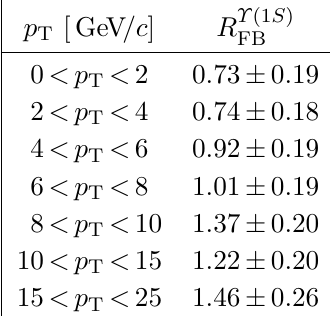
, as a function of p T integrated over j y (cid:3) j in the FB